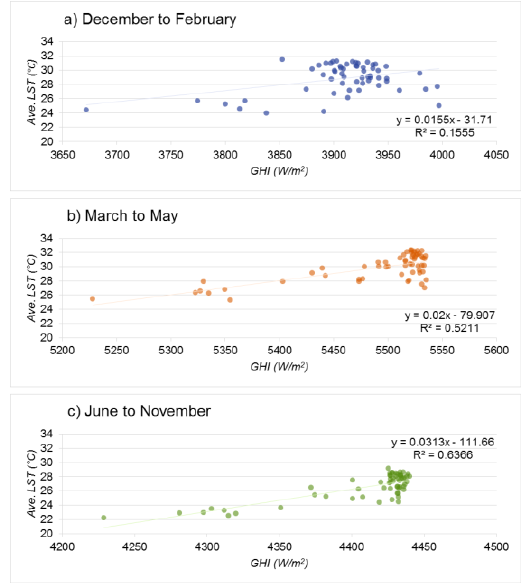
Figure 8. LST vs. GHI for the barangays of Cebu City in the a) cool dry season, b) hot dry season, and c) wet season.